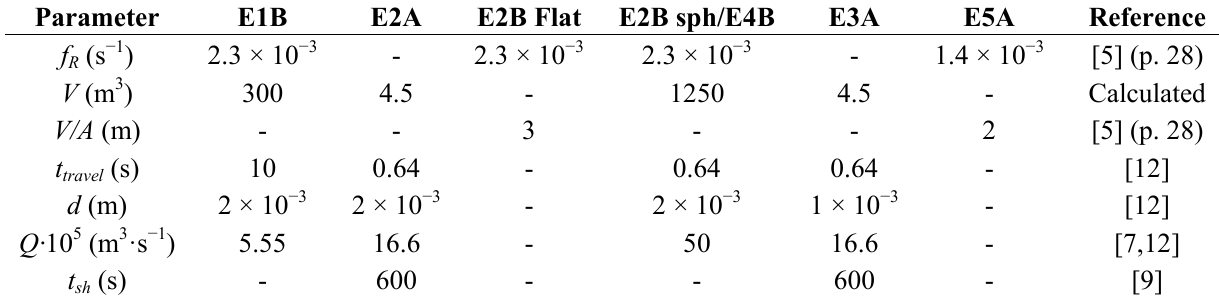
Table 4. Volatilization parameters for indoor scenarios.